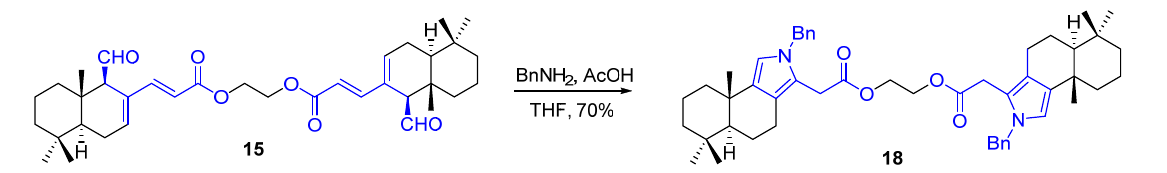
Figure 3. Synthesis of dimeric polygodial-based crosslinking agents 15 , 16 and 17.